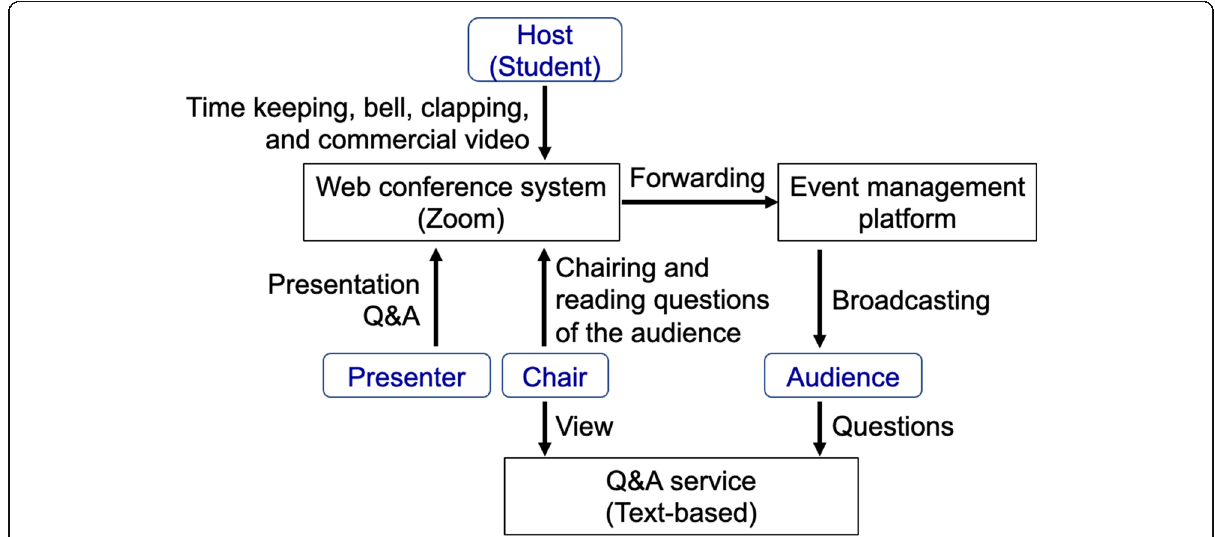
Fig. 1 Conceptual diagram of the conference system used in